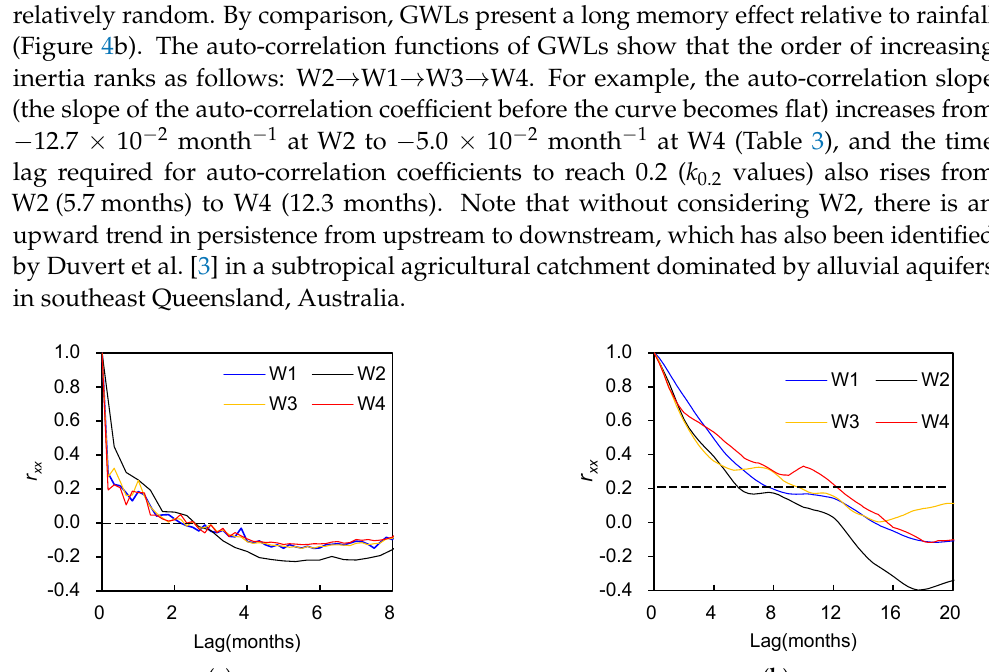
Table 2. Test results of the Mann–Kendall trend analysis.